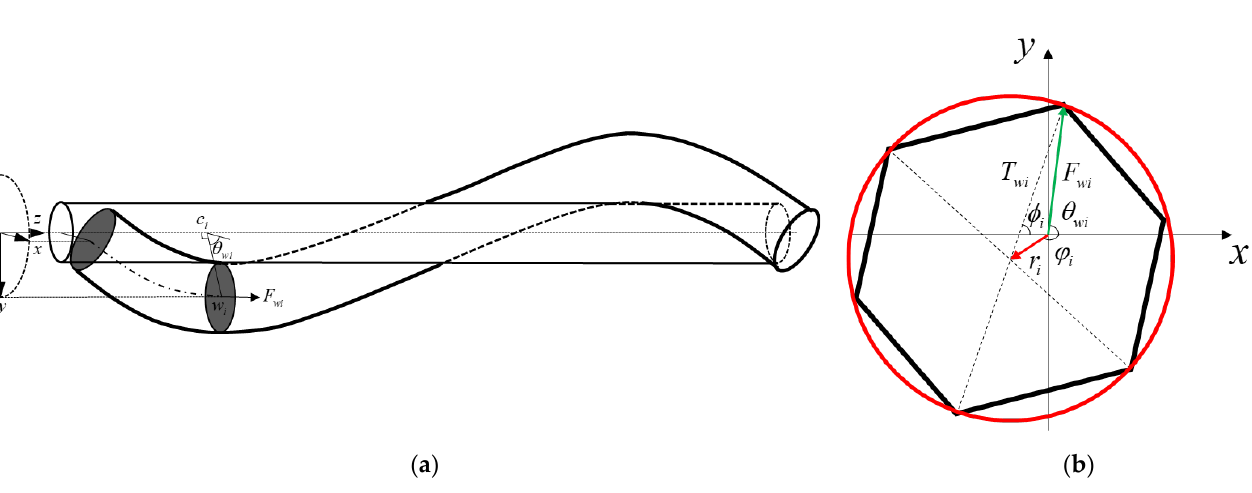
; ( b ) a force 𝜃𝜃 𝑤𝑤𝑖𝑖